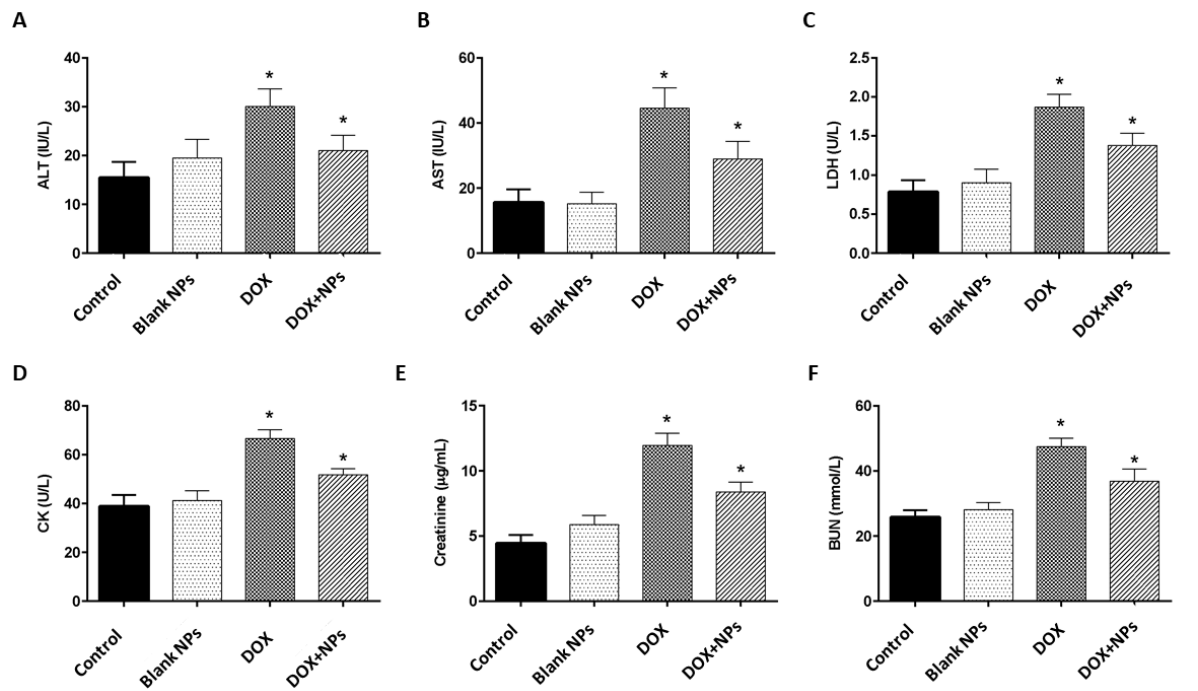
Figure 6: Serum levels of biochemical parameters in rats after treatment with free DOX, DOX-nanocarrier (DOX + NPs), and free nanocarrier (Blank NPs). A. Alanine aminotransferase (ALT), B. Aspartate aminotransferase (AST), C. Lactate dehydrogenase (LDH), D. Creatine kinase (CK), E. Creatinine and F. Blood urea nitrogen (BUN) in experimental groups. The values are represented as mean ± SD (n = 6 animals in each group). * P < 0.05, when compared to